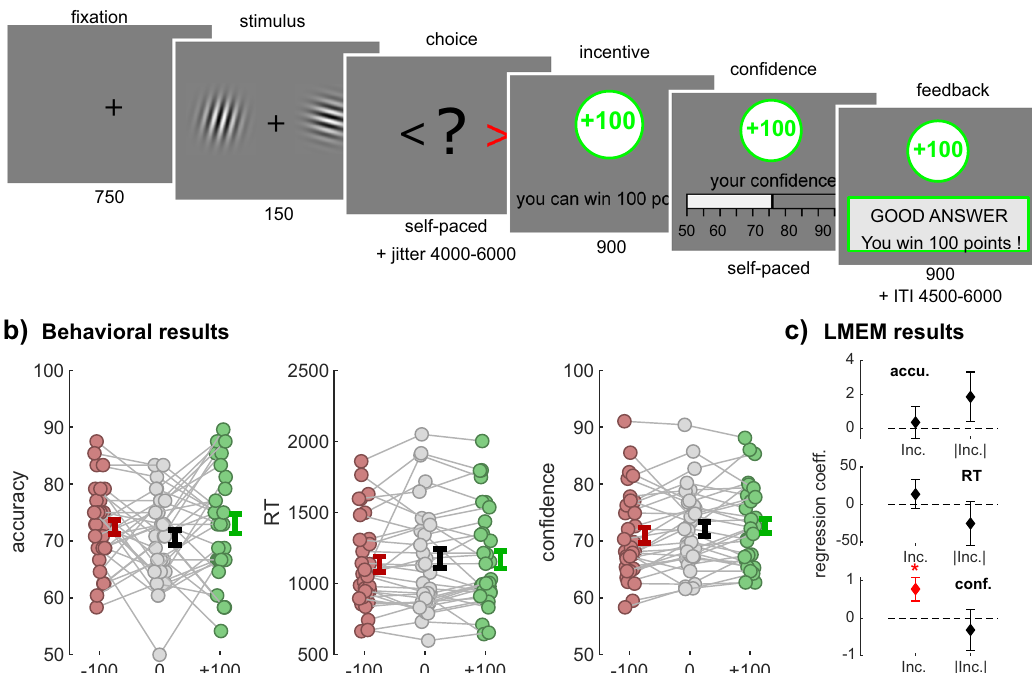
Fig. 1 Experimental design and behavioral results. a Experimental paradigm. Participants viewed two Gabor patches on both sides of the screen (150 ms) and then chose which had the highest contrast (left/right, self-paced). After a jitter of a random interval between 4500 and 6000 ms, the incentive condition was shown (900 ms; green frame for win trials, gray frame for neutral trials, red frame for loss trials). Afterwards, participants were asked to report their con fi dence in the earlier made choice on a scale ranging from 50% to 100% with steps of 5%. The initial position of the cursor was randomized between 65% and 85%. Finally, subjects received feedback. The inter-trial interval (ITI) had a random duration between 4500 and 6000 ms. The calibration session only consisted of Gabor discrimination, without con fi dence rating, incentives, or feedback, and was used to adjust the dif fi culty so that every individual reached a performance of 70%. b Behavioral results. Individual-averaged accuracy (left), reaction times (middle) and con fi dence (right) as a function of incentive condition ( − 100/red, 0/gray, + 100/green). Colored dots represent individuals ( N = 32), gray lines highlight within-subject variation across conditions. Error bars represent sample mean ± standard error of the mean. Note that for con fi dence and accuracy, we computed the average per incentive level per individual, but that for reaction times, we computed the median for each incentive condition rather than the mean due to their skewed distribution. c Linear mixed-effect model (LMEM) results. The graph depicts fi xed-effect regression coef fi cients ( β ) for incentive condition (Inc.) and absolute incentive condition (|Inc.|) predicting performance (top), reaction times (middle), and con fi dence (bottom). Error bars represent standard errors of fi xed effects. * p <